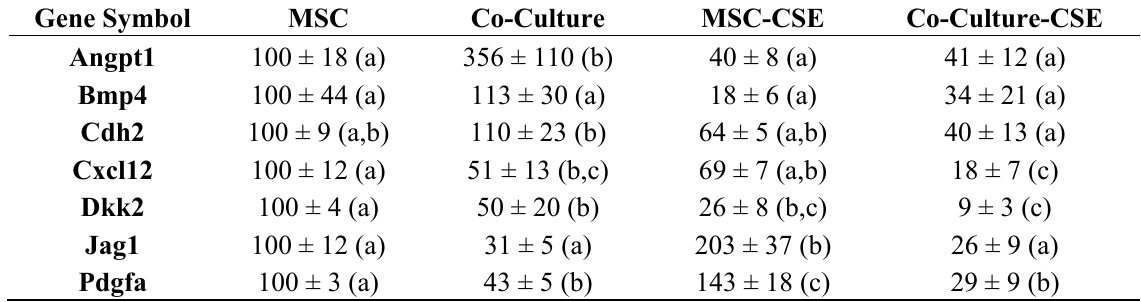
Table 2. RT-qPCR analysis of MSC niche mediators from control and smoke-exposed animals were cultured alone or co-cultured with naïve Lin-GFP+ HSPCs for 1 day. Smoke exposure led to down regulation of all but two of the analyzed genes, Jagged1 and Platelet-derived growth factor- α . Data are expressed as a percent change from control ± SEM (MSC alone). Different letters in parenthesis next to the percent values signify statistical significance; p < 0.05. Abbreviations: Angiopoietin 1 (Angpt1); Bone morphogenic protein 4 (Bmp4); N -cadherin (Cdh2); Chemokine (C-X-C motif) ligand 12 (Cxcl12); Dikkopf 2 (Dkk2); Jagged 1(Jag1); Platelet-derived growth factor alpha (Pdgfa). Gene Symbol MSC Co-Culture MSC-CSE Co-Culture-CSE